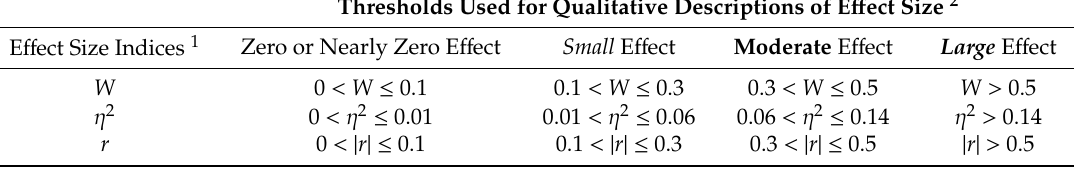
Table 1. Thresholds for interpreting e ff ect size. Thresholds Used for Qualitative Descriptions of E ff ect Size